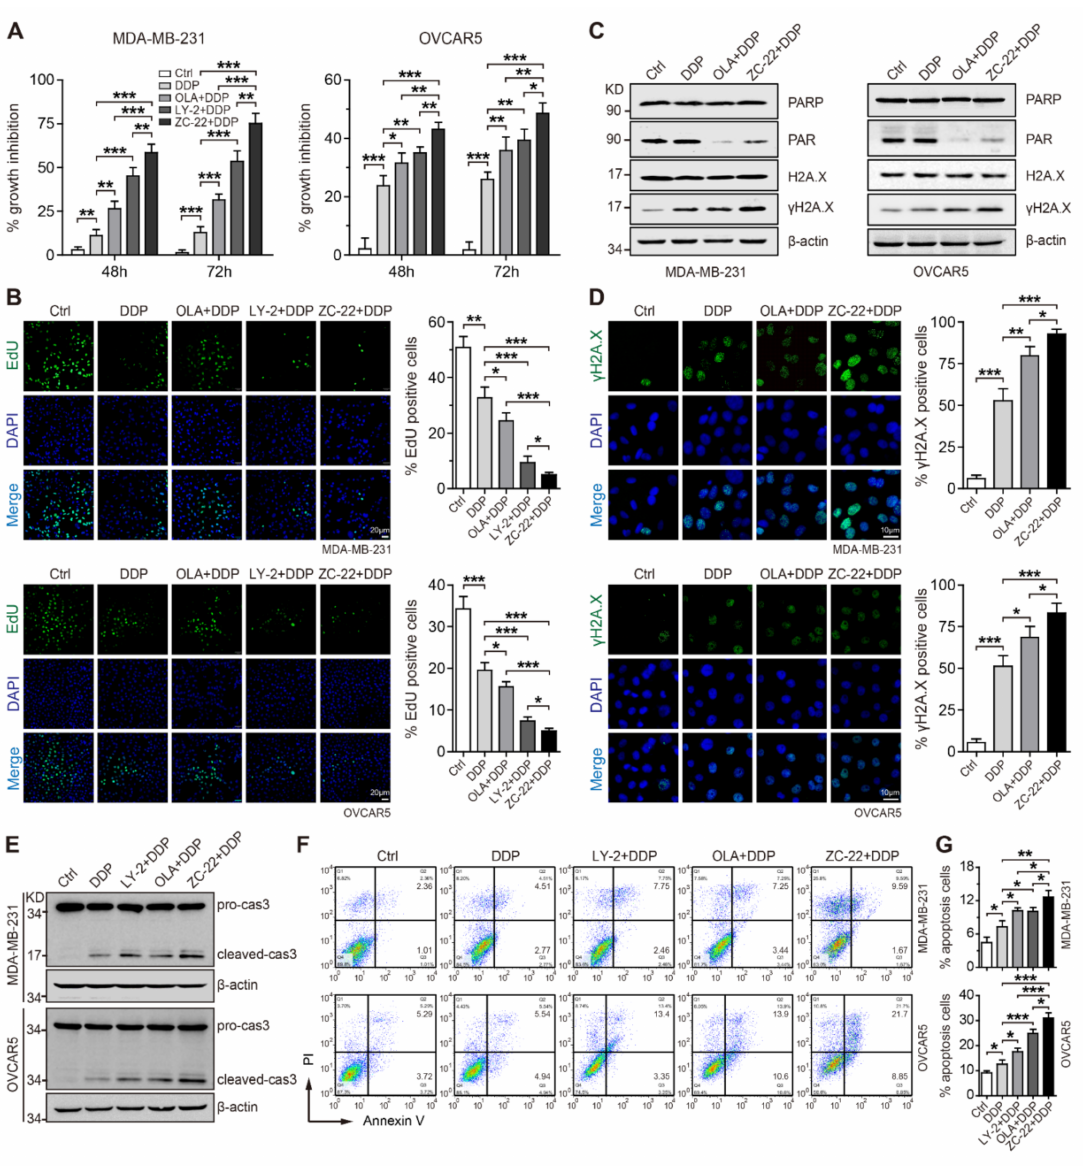
Figure 5. ZC-22 increases the sensitivity of breast and ovarian cancer cells to cisplatin. MDA-MB-231 or OVCAR5 cells were treated with 2.5 µ M cisplatin (DDP) alone or together with 2 µ M Olaparib (OLA), LY2835219 (LY-2), or ZC-22 for the indicated time. ( A ) CCK-8 assays of MDA-MB-231 (left) and OVCAR5 (right) cells treated with DDP alone or together with OLA, LY-2, or ZC-22 for 48 or 72 h, n = 4. ( B ) EdU incorporation analysis of MDA-MB-231 (Up) and OVCAR5 (Down) cells treated with DDP alone or together with OLA, LY-2, or ZC-22 for 24 h. Representative pictures of EdU staining are shown in the left panels, and quantification of percentage of EdU-positive cells was presented in the bar graphs on the right, n = 3. ( C ) Western blot analysis of PARP, PAR, and γ H2A.X/H2A.X in MDA-MB-231 (left) and OVCAR5 (right) cells treated with DDP alone or together with OLA or ZC-22 for 48 h. ( D ) Representative pictures (left) and quantification of percentage (right) of γ H2A.X-positive cells in MDA-MB-231 (top panels) and OVCAR5 (bottom panels) cells treated with DDP alone or together with OLA or ZC-22 for 24 h, n = 3. ( E ) Western blot analysis of caspase 3 (cas3) cleavage in MDA-MB-231 (top) and OVCAR5 (bottom) cells treated with DDP alone or together with LY-2, OLA, or ZC-22 for 48 h. ( F , G ) Representative pictures ( F ) and quantification of percentage ( G ) of apoptotic cells in MDA-MB-231 (top panels) and OVCAR5 (bottom panels) cells treated with DDP alone or together with LY-2, OLA, or ZC-22 for 48 h, n = 3. Values in all panels are means ± SD. * p < 0.05, ** p < 0.01, and *** p < 0.001 in an unpaired t